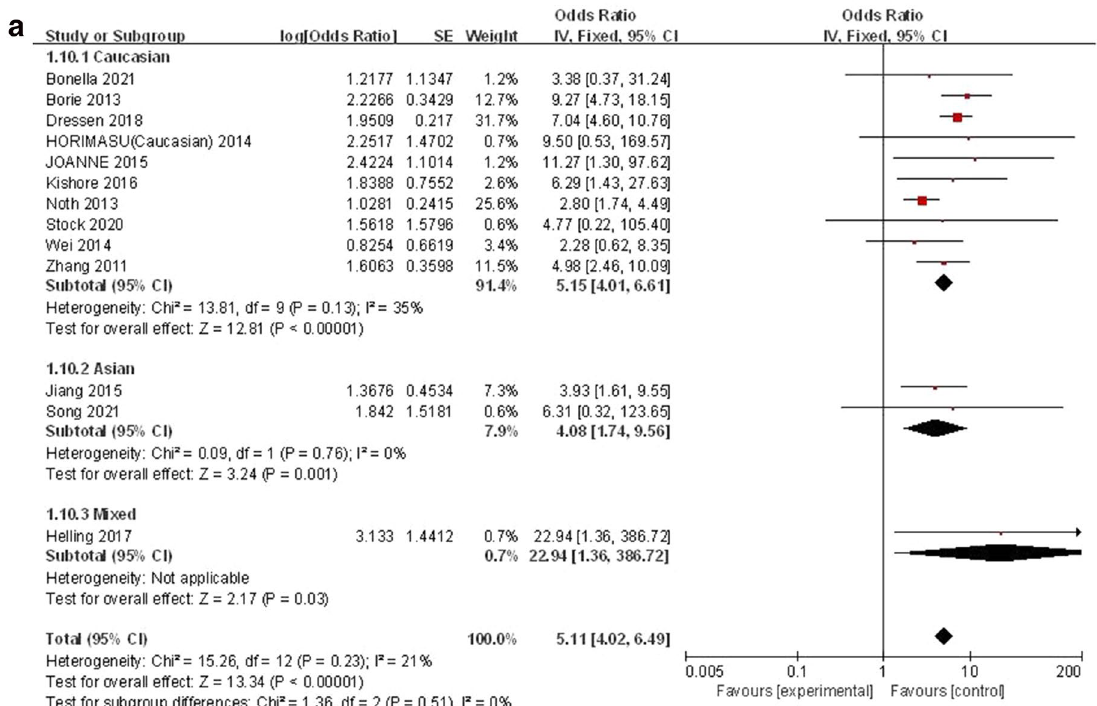
Figure 6. The TT vs. GG + GT model was used to evaluate the correlation between MUC5B gene polymorphism and IPF susceptibility. ( a ) Forest plot of TT vs. GG + GT genetic model. ( b ) Trial sequential analysis of MUC5B polymorphism and IPF risk using the recessive genetic model (TT vs. GG + GT) (Adjusted Boundaries Print). The combined sample size (N = 11,454) exceeded RIS (N = 11,030), the cumulative Z curve crossed the conventional boundary and the TSA boundary, and the association was established in advance. ( c ) Inverted funnel chart of TT vs. GG +